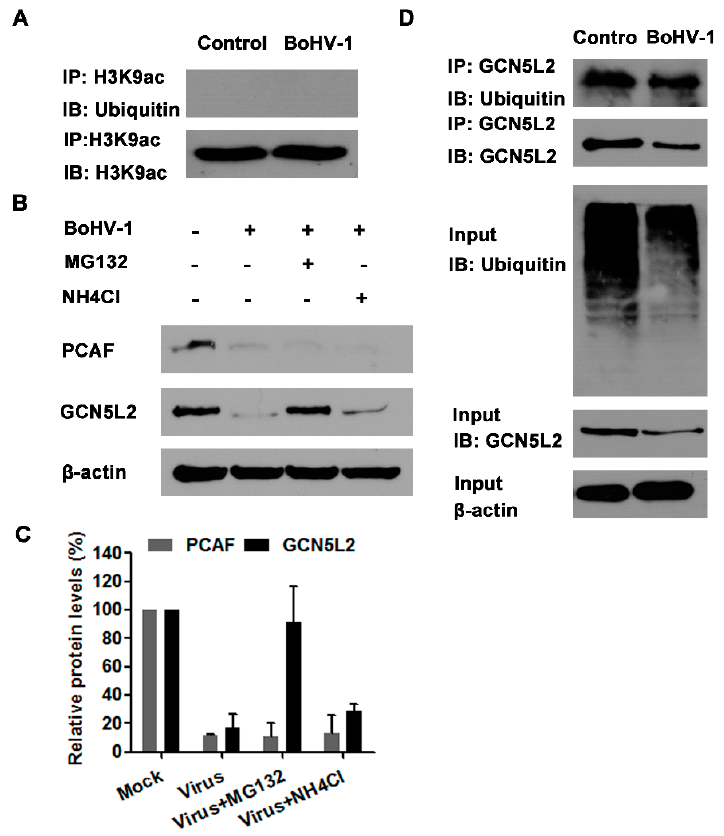
Figure 6. The ubiquitin-proteasome pathway mediated GCN5L2 degradation. ( A , D ) MDBK cells in 60 mm dishes were mock infected or infected with BoHV-1 (MOI = 1) for 24 h. The cell lysates were